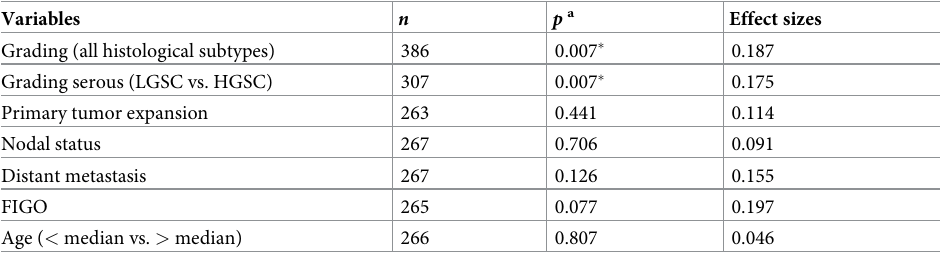
Table 3. Correlation analysis within the OC cohort regarding grouped immunoreactive score (0–2, 3–8, 9–12). Variables n p a Effect